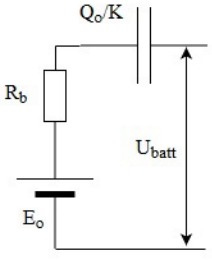
Figure 5. Equivalent circuit of battery.